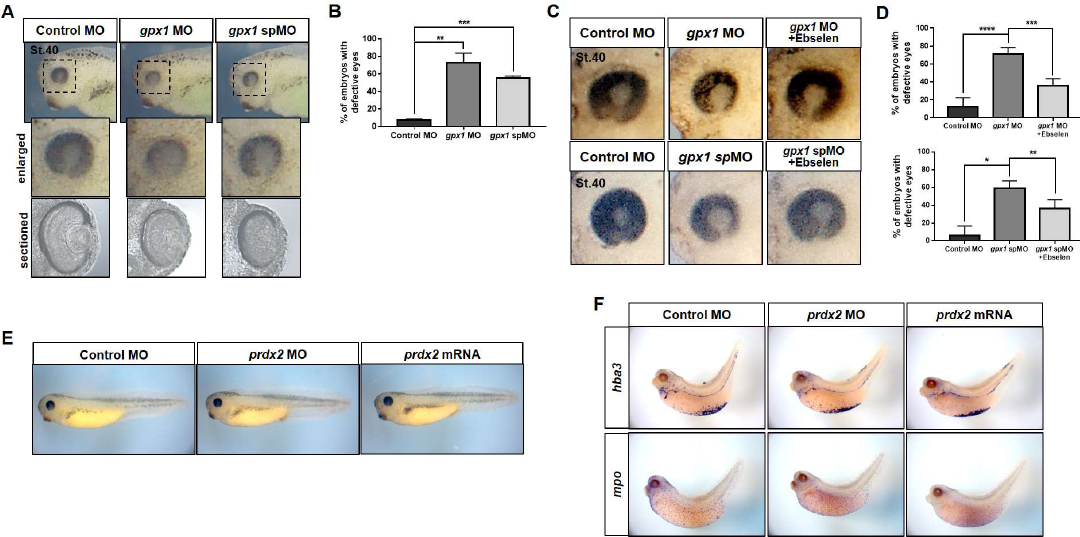
Figure 2. gpx1 loss-of-function results in malformed eyes with incompletely detached lenses, while prdx2 morphant embryos have no phenotypic malformations. ( A ) Two types of gpx1 morpholino oligonucleotides (MOs), i.e., translational blocking MO ( gpx1 MO; 20 ng) and splicing blocking MO ( gpx1 spMO; 5 ng), were microinjected into animal poles of two-cell stage Xenopus embryos, and then the embryos were fixed at NF. St. 40. Knockdown of gpx1 in both groups of MOs resulted in malformed eyes, as shown in the enlarged images. Additionally, the cross-sectional analysis indicated the incompletely detached lens in both groups of gpx1 morphants. ( B ) The statistical analysis of gpx1 morphants indicated that more than 70% of the embryos exhibited malformed eyes in the case of gpx1 MO microinjection, while more than 50% of embryos showed eye malformations in the case of gpx1 spMO injection compared with the control embryos. ** p ≤ 0.01, *** p ≤ 0.001. ( C ) Rescue experiments were conducted by transferring the gpx1 morpholino injected embryos to 0.5- µ M ebselen, a Gpx mimic, and then fixed at NF. St. 40. The eye malformations observed in both groups of gpx1 -depleted embryos were effectively recovered after ebselen treatment. ( D ) A graphical representation of rescued embryos showed that more than 30% of embryos recovered the malformed eyes observed due to gpx1 MO and gpx1 spMO microinjection after ebselen treatment. * p ≤ 0.05 ** p ≤ 0.01, *** p ≤ 0.001, **** p ≤ 0.0001. ( E ) prdx2 MO (40 ng) and wildtype prdx2 mRNA (1 ng) were microinjected into the two cell stage developing embryos and then the embryos were fixed at NF. St. 40. The embryos developed normally after prdx2 MO injection and there were no phenotypic differences between prdx2 morphant embryos and embryo injected with wildtype prdx2 mRNA. Both group of embryos were morphologically similar to the control MO injected embryos. ( F ) Xenopus embryos were injected with prdx2 MO and were processed for WISH analysis using blood cell markers, i.e., hba3 and mpo . The knockdown of prdx2 did not affect the expression pattern of the blood cell-specific